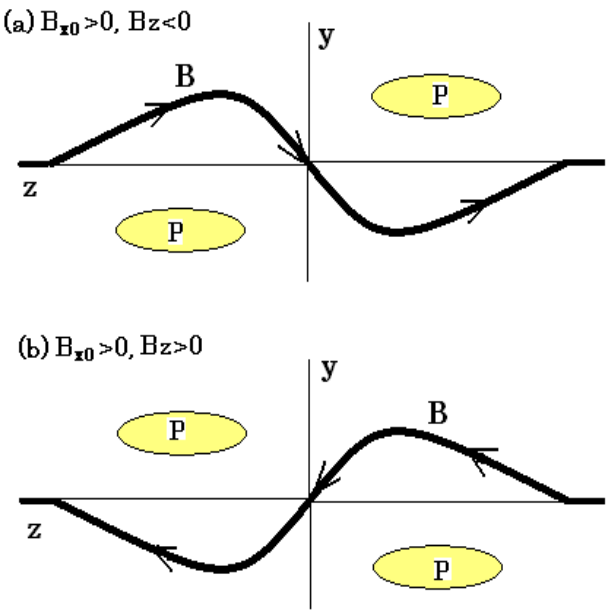
Fig. 14. Schematic drawings of the sheared field lines (solid lines) and the cross section of the high-pressure part of the distorted plasmoid, denoted by P , in the (y,z) plane at a fixed location of Figure 14: (Color online) Schematic drawings of the sheared x(>X C ) for the cases (a) B x 0 > 0 and B z < 0, and (b) B x 0 > 0 and B z > 0. fleld lines (solid lines) and the cross section of the high- pressure part of the distorted plasmoid, denoted by P , in the ( y; z ) plane at a flxed location of x ( > X C ) for the cases (a) in the long current sheet system. The basic features of the plasmoid evolution are, at least qualitatively, not influenced B x 0 > 0 and B z < 0, and (b) B x 0 > 0 and B z > 0. by the initial sheared field. That is, the plasmoid is formed as a result of the drastic plasma compression at the plasmoid backward end at x = X P ahead of the fast (Alfv ´ enic) recon- nection jet. It propagates along the antiparallel magnetic fields and its propagation tends to be distorted in the direc- tion of the sheared field. Inside the plasmoid, the magnetized plasmas, which have been swept away by the fast reconnec- tion outflow jet u x , are accumulated. The magnetic field lines that have been piled up inside the plasmoid are composed of the two types topologically different. The sheared field lines accumulated in X P < x < X C are the field lines that have been reconnected at the X neutral line, whereas in X C < x the sheared field lines initially embedded in the central current sheet are accumulated in the form of a core (Fig. 8). Hence, the plasmoid center x = X C is the position that bounds the reconnected field lines and the field lines without reconnec- tion, so it may correspond to the so-called contact disconti- nuity. Accordingly, the reconnected field lines are not spiral or helical, since the field lines in x < X C are never connected topologically to those in x > X C (Figs. 4 and 7). plasmoid is that the B y field component becomes negative for x > X C and hence changes its sign at x = X C , where the accumulated sheared field | B z | has the peak value (Figs. 6 and 8); also, the negative value of B y for x > X C tends to